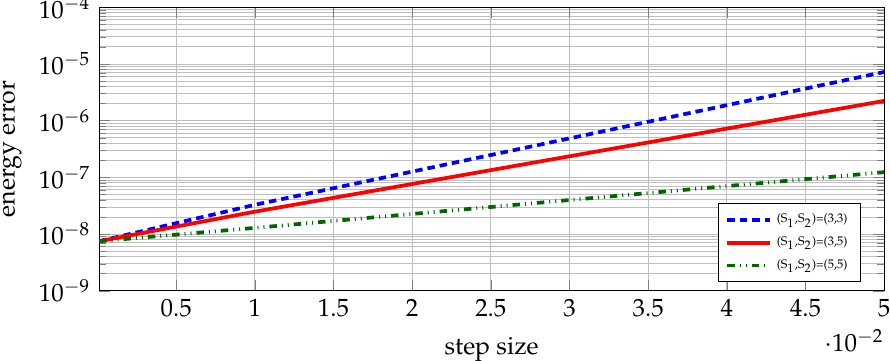
Figure 2. Modified satellite solar system. Global error for the energy error using the proposed family of exponential methods for S 1 = 3, S 2 = 5 (red line), S 1 = 5, S 2 = 5 (green line) and the ones that use S 1 = S 2 = 3 (blue line).